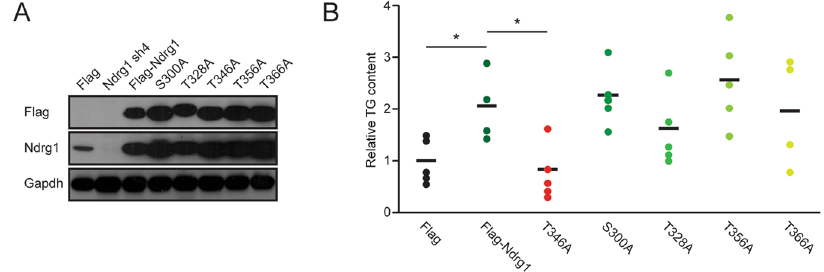
Figure 4. Sgk1-dependent phosphorylation of Ndrg1 is required for its pro-adipogenic function. ( A ) Western blot assessing the levels of expression of different FlagNdrg1 phospho-mutant proteins using the indicated antibodies. ( B ) Relative TG content in differentiated 3t3l1 cells expressing the indicated phospho-mutants of Ndrg1. Each data point represents an average TG content of individually generated and differentiated mixed stable cell populations of 3t3l1 cells expressing different Ndrg1 mutants. ( * P < 0.05 according to ANOVA followed by the Post hoc Tukey